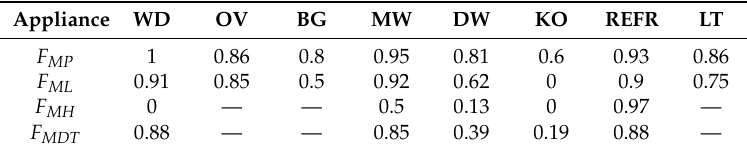
Table 2. Performance of four low-rate NILM algorithms for House 1.